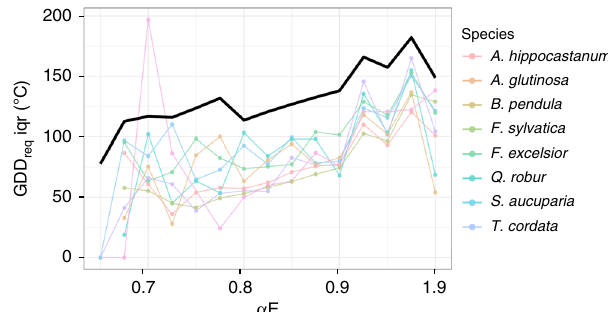
Fig. 3 Effect of aridity on GDD req spatial variance. Variation of the interquartile (iqr) of the long-term (1970 – 2016) heat requirement (GDD req , estimated as the sum of temperatures > 5 °C between 1 January and the LU date) as a function of the ratio of actual to potential evapotranspiration ( α E). Low α E values indicate drought conditions during the growing season. The black line represents the iqr of GDD req when considering all sites and species. See Supplementary Fig. 4 for the distribution of GDD req values along α E. Source data are provided as a Source Data fi